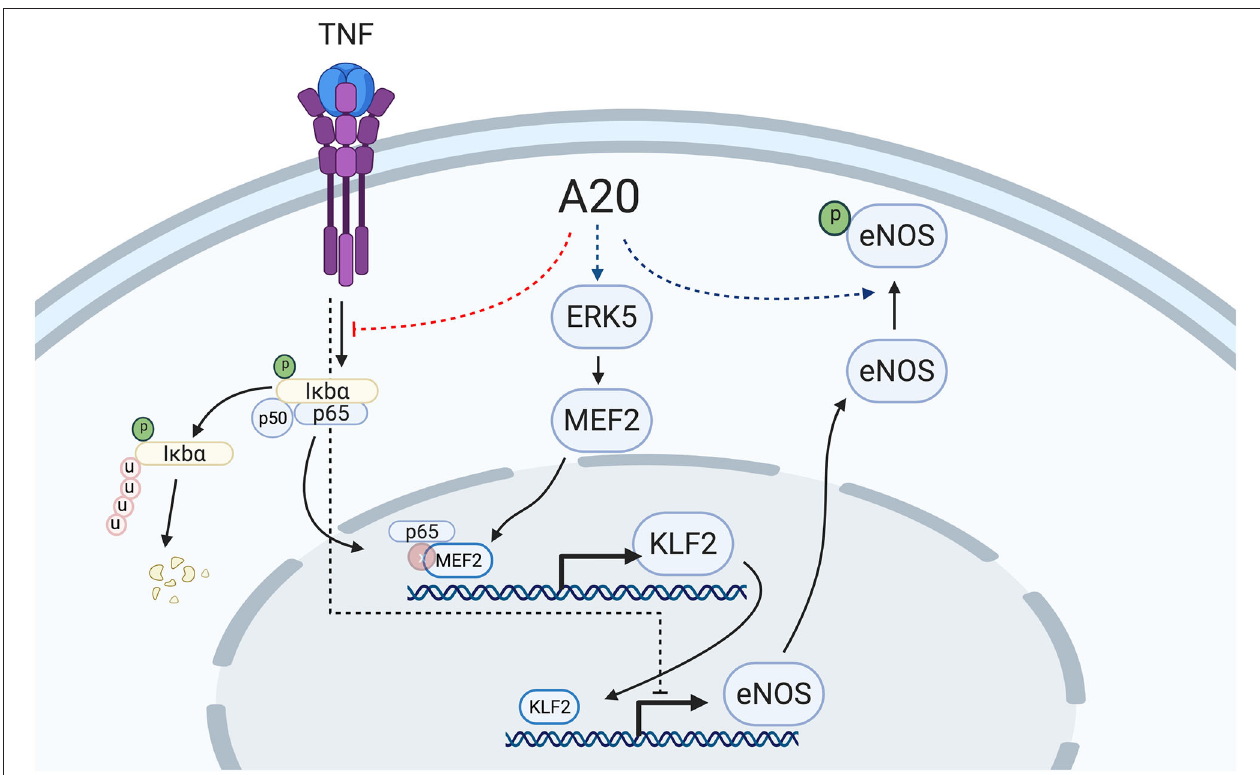
FIGURE 7 | Proposed mechanism of A20-induced prevention of EC dysfunction by increasing eNOS transcription and Ser-1177 activating phosphorylation. A20 overexpression in EC increases basal eNOS transcription in an ERK5-dependent manner with subsequent upregulation of the eNOS transcriptional regulator, KLF2. Overexpression of A20 in EC also precludes TNF-induced decrease of eNOS and KLF2, likely through inhibition of NF- κ B activation, precluding p65 translocation to the nucleus and its subsequent binding to the KLF2 transcriptional regulator, MEF2. Additionally, A20 overexpression in EC increases basal Ser-1177 phosphorylation of eNOS, which is indispensable for the function of this enzyme. The mechanism(s) behind this latter effect remains to be elucidated. Red dotted lines delineate downregulation by A20, while blue dotted lines delineate upregulation by A20. Scheme was created using